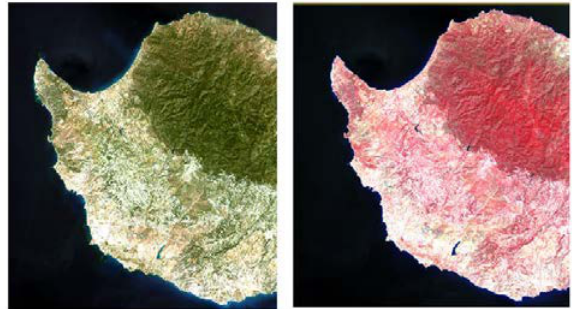
Figure 4. The city of Paphos in the year 2016: (left) Red – Green – Blue (RGB) true colour composite i.e. the band combination that corresponds to the human vision; and (right) in NIR – green – blue pseudo colour composite that enhances the presence of vegetation (in red colour).